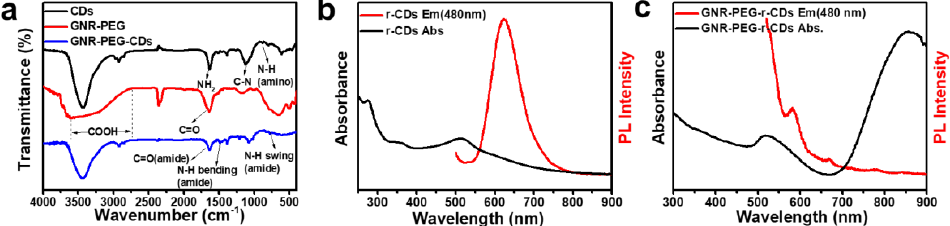
Figure 2. ( a ) The Fourier transform infrared (FT-IR) spectra of CDs, GNR-PEG and GNR-PEG-CDs; ( b ) the UV-vis and PL spectra (excited at 480 nm) of CDs; ( c ) the UV-vis and PL spectra (excited at 480 nm) of GNR – PEG – CDs.